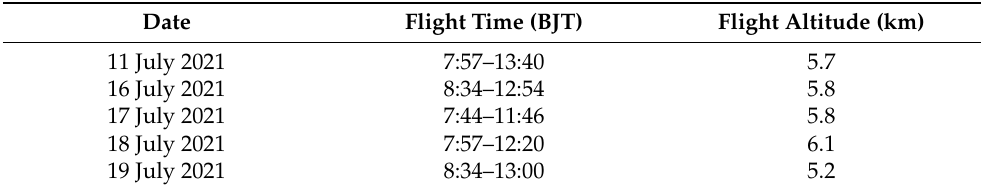
Figure 3. The flight routes between 11 and 19 July 2021. (© Google Earth Pro). Table 2. Details of the flights carried out during the airborne campaign.